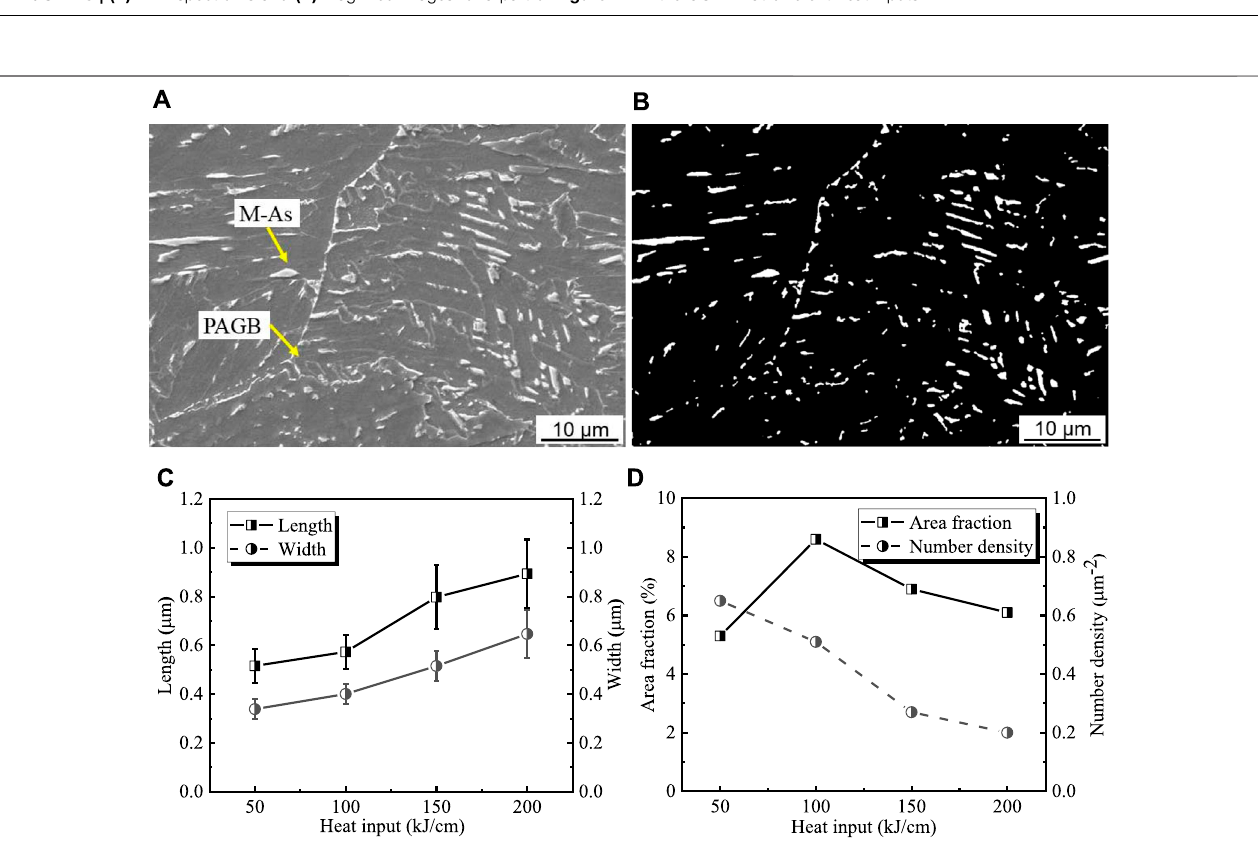
FIGURE 9 | (A) Typical morphologies of M – A constituents, (B) M – A constituents changed into white color using ImageJ, and measured (C) length and width and (D) area fraction and number density of M – A constituents in the CGHAZ at different heat inputs.